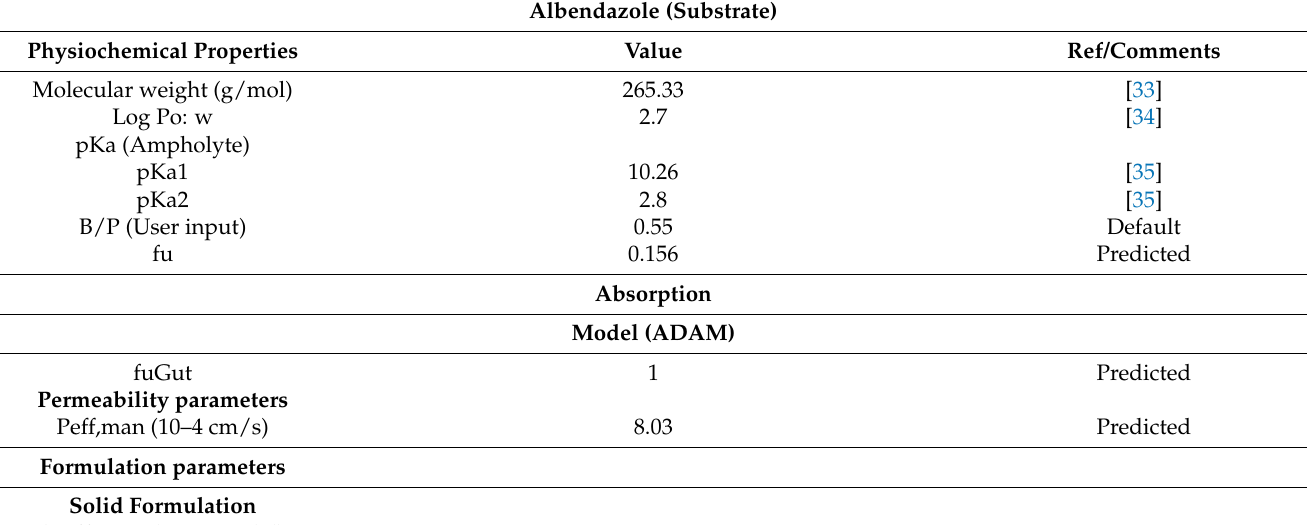
Table 1. Summary of the PBPK parameters for albendazole (substrate) and albendazole sulfoxide (primary metabolite) used in